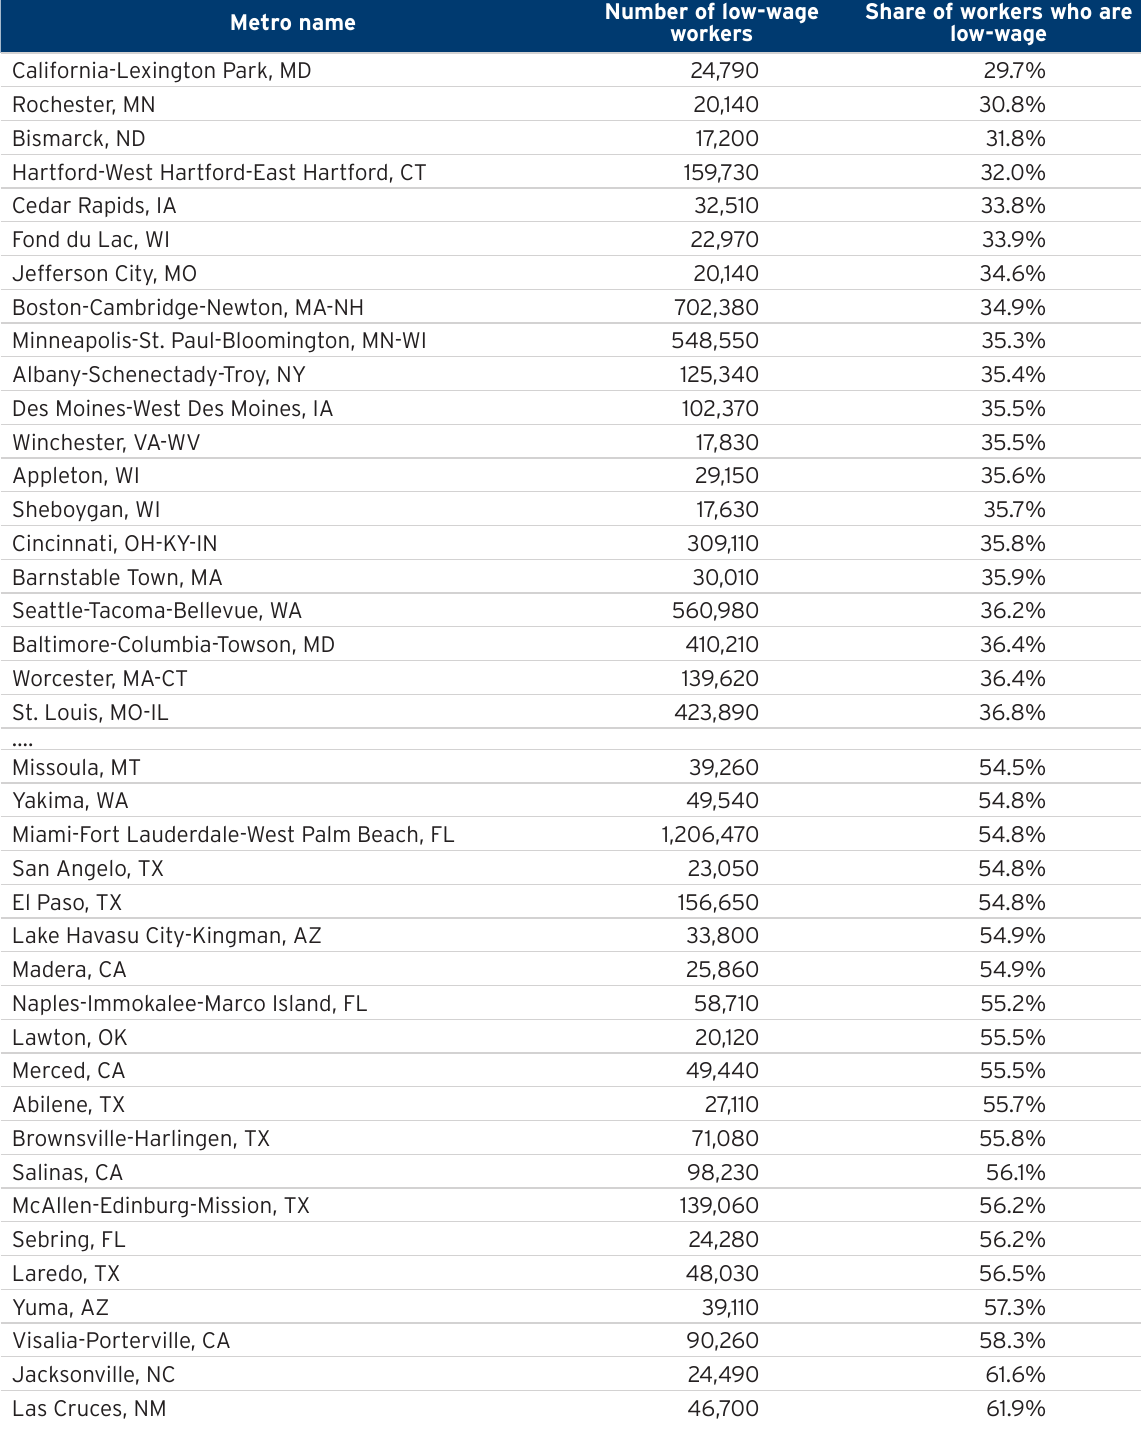
Source: Brookings analysis of 2012-2016 American Community Survey 5-year Public Use Microdata